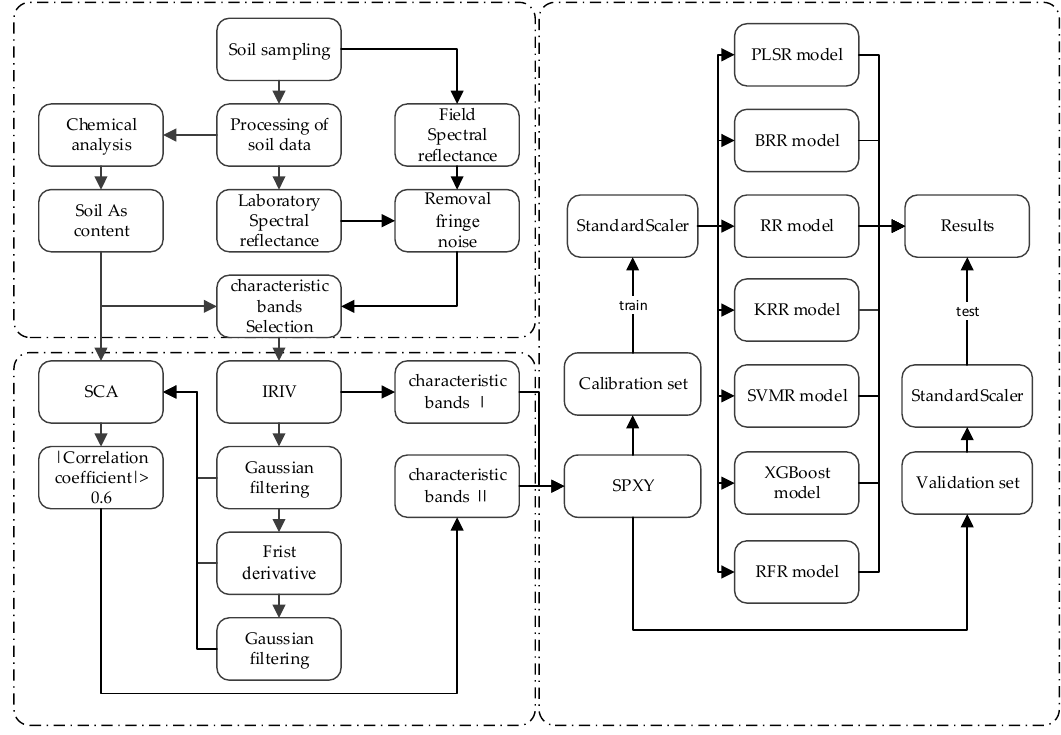
Figure 2. The technical flowchart of the algorithm proposed in this paper.